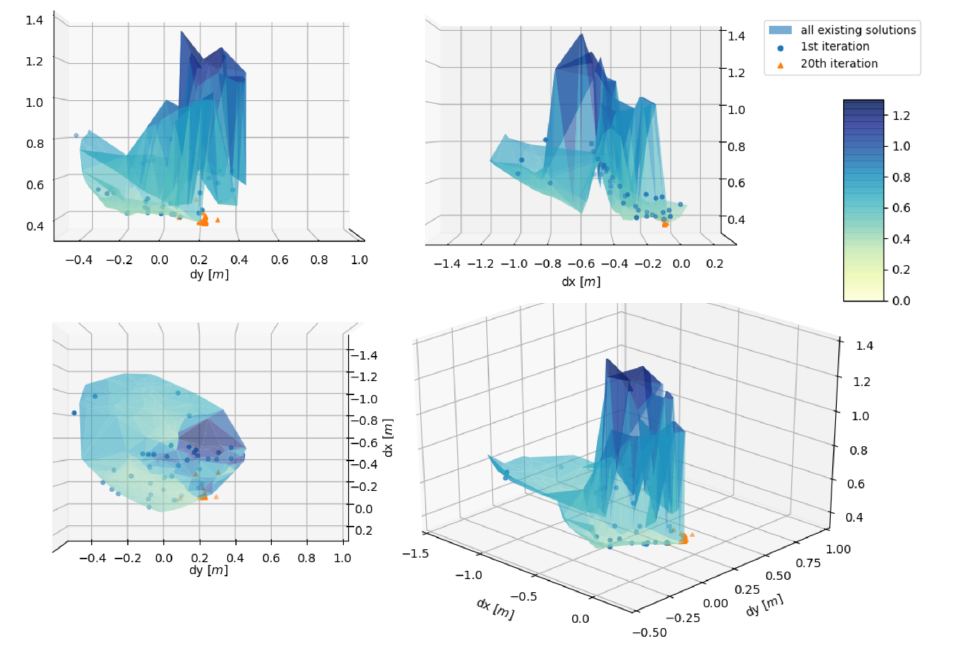
Figure 13. Specific transport cost [USD] in terms of the displacement vector of the robot base [dx,dy]